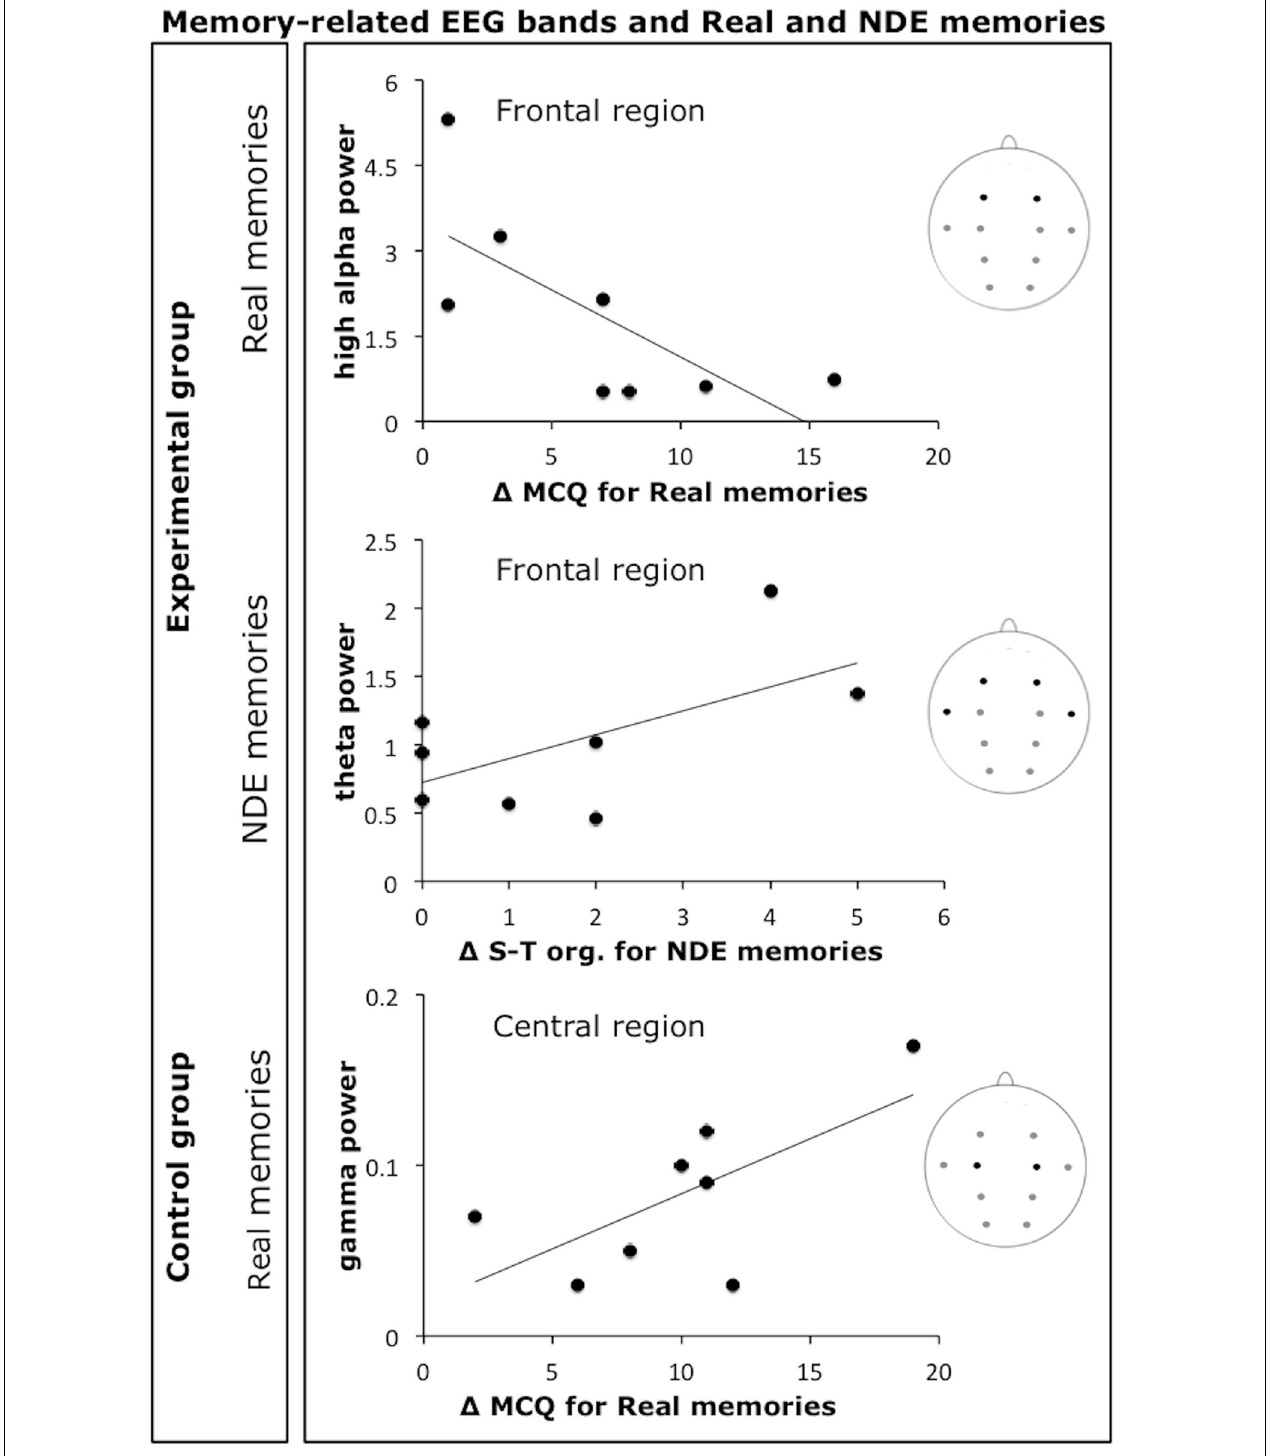
FIGURE 2 | Scatterplots of a subset of observed correlations between memory-related EEG frequency bands (high alpha, theta, and gamma) and individual (cid:2) MCQ scores or (cid:2) MCQ subscales scores. Scatterplots show the most relevant correlations for the real